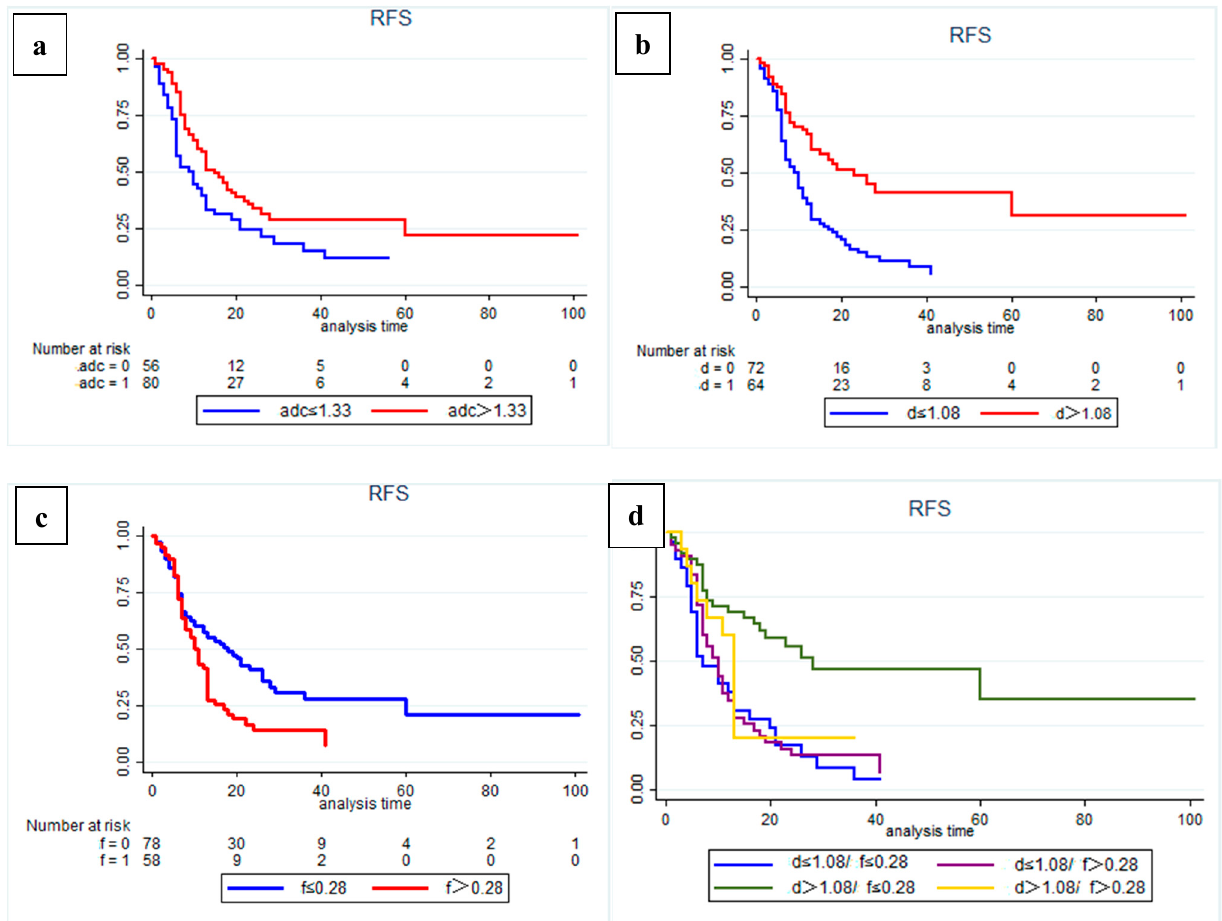
Figure 3. Kaplan–Meier curves showing recurrence-free survival (RFS) with clear differences in ( a ) high-ADC value group (sADC > 1.33 × 10 − 3 mm 2 /s) and low-ADC value group (sADC ≤ 1.33 × 10 − 3 mm 2 /s); ( b ) high-D value group (sD > 1.08 × 10 − 3 mm 2 /s) and low-D value group (sD ≤ 1.08 × 10 − 3 mm 2 /s); ( c ) low-f group (sf ≤ 0.28) and high-f group (sf > 0.28). ( d ) Subgroup analysis showed that patients in the high-D value combined with low-f value group had a significantly better RFS than patients in the other subgroups ( p = 0.001).